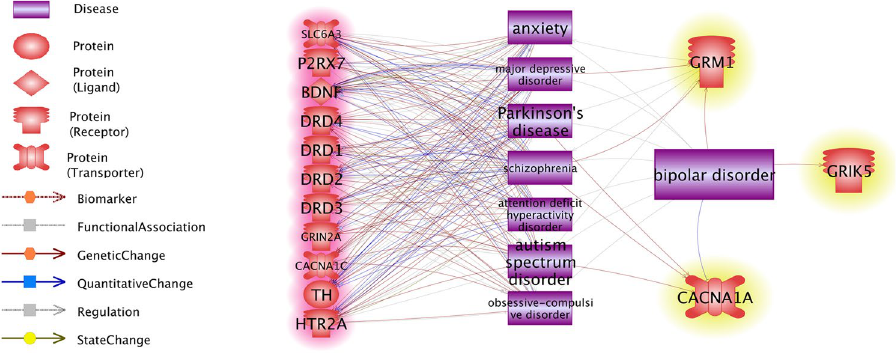
Figure 3. Top BP genes selected by cross-metrics analysis and their relationships to other diseases. The 11 genes that shared overlap in RScore, PScore and SScore groups are highlighted in red; The 3 genes that shared overlap in AScore, PScore and SScore groups are highlighted in yellow. The network was built using the ‘network building’ module of Pathway